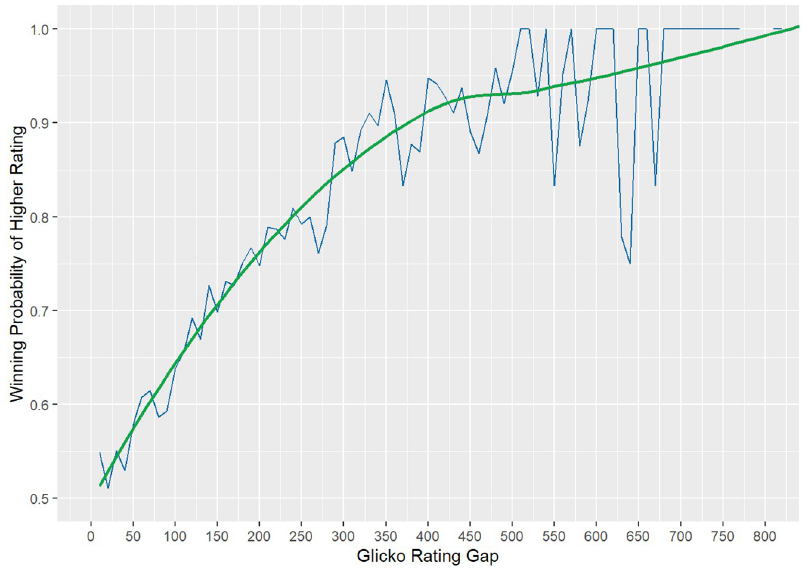
Fig 6. Winning probability of higher-rated player vs. rating